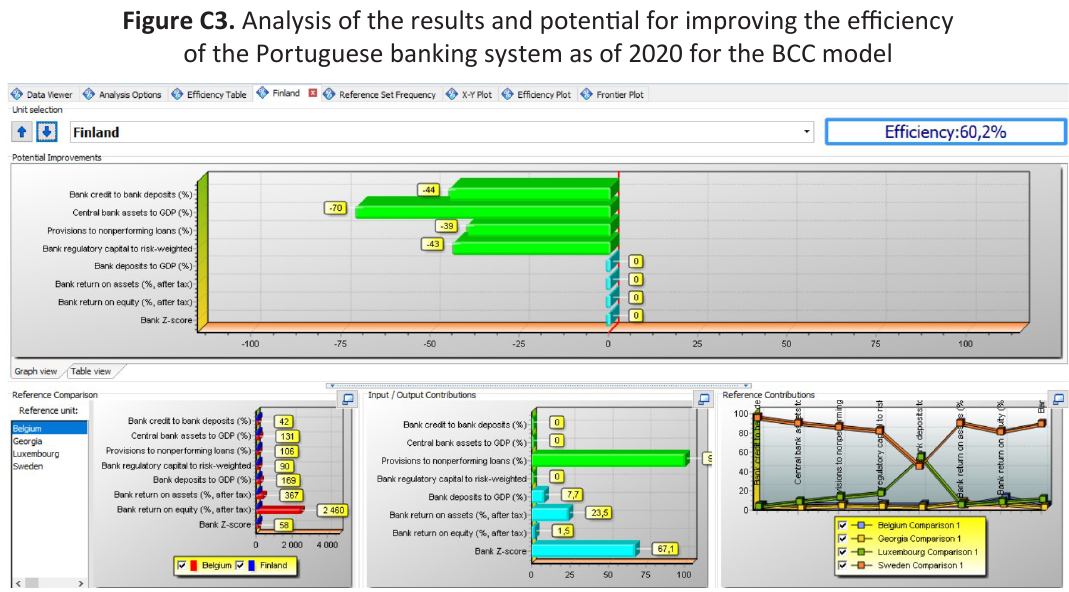
Figure C4. Analysis of the results and potential for improving the efficiency of the Finnish banking system as of 2020 for the BCC